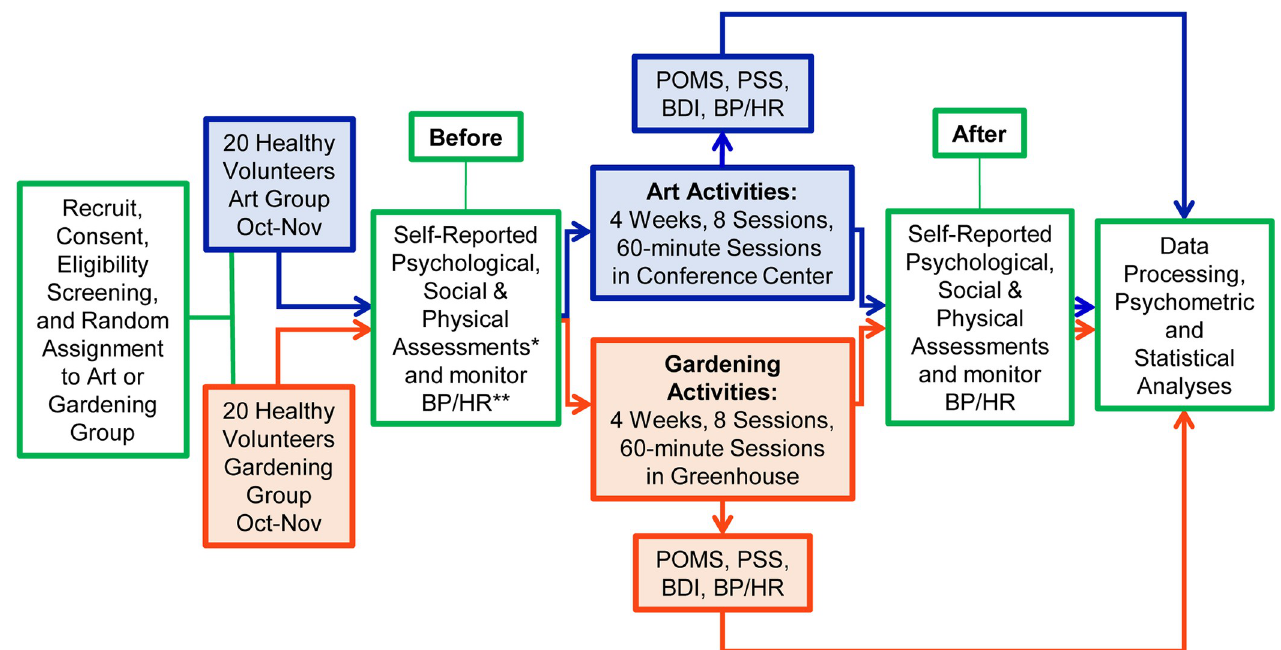
Fig 2. Study experimental design. Self-report psychometric assessments � included the Profile of Mood States 2nd Ed. Adult Form (POMS); Perceived Stress Scale (PSS); Beck Depression Inventory 2nd Ed. (BDI-II); State-Trait Anxiety Inventory Adult Form (STAI); Satisfaction with Participation in Discretionary Social Activities (SPDSA) PROMIS Short Form v1.0; and SF-36v2 (SF-36) Health Survey 3rd Ed. Blood Pressure �� (BP) and Heart Rate �� (HR) were collected using Omron 7 Series Wrist Blood Pressure Monitors (BP652N).